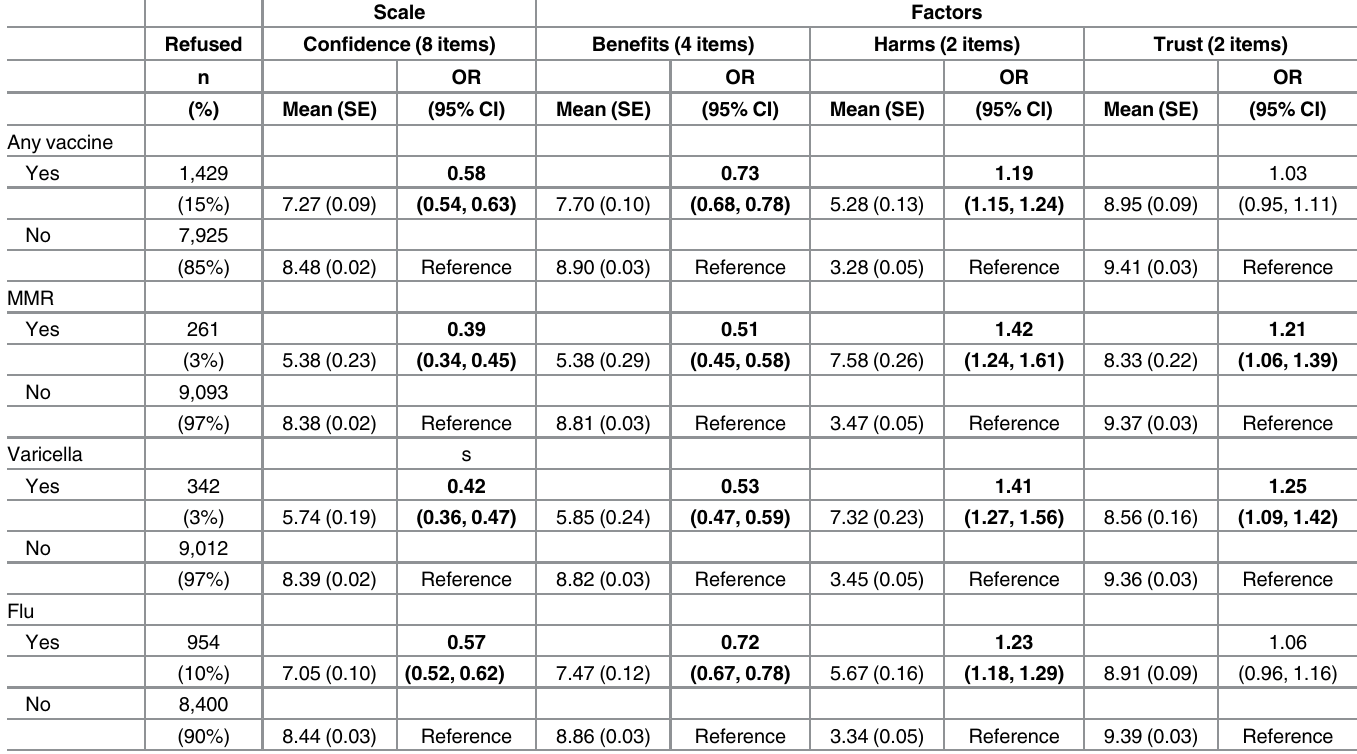
Table 2. Parent-reported vaccine refusal: Multivariable associations with scale and factor score means ( n = 9,354). Scale